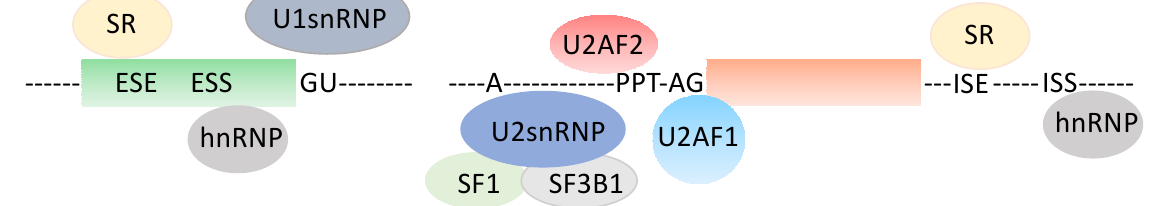
Figure 1. Generic splice unit. ESE: Exonic Splice Enhancer, ESS: Exonic Splice Silencer, ISE: Intronic Splice Enhancer, ISS: Intronic Splice Silencer, PPT: polypyrimidine tract, hnRNP: heterogenous nuclear ribonucleic particle, snRNP: small nuclear ribonucleic particle, SR: serine arginine ‐ rich RNA ‐ binding protein.